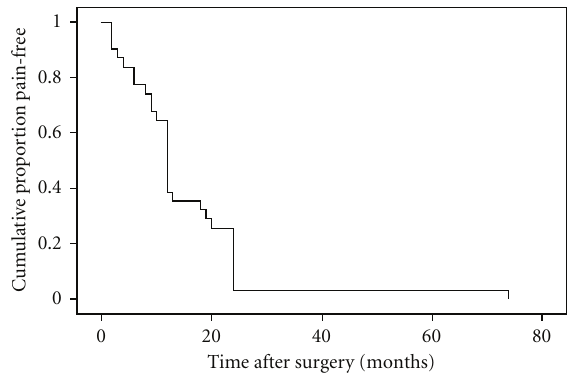
Figure 3: Kaplan-Meier plot illustrating pain-free proportion of patients after a percutaneous trigeminal ganglion balloon compres- sion. Mean pain-free period was 15